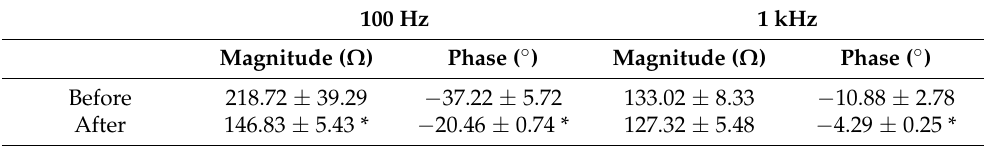
Table 1. EIS measurements before and after short-term test. 100 Hz 1